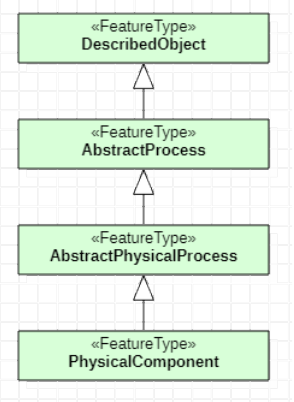
Figure 2. Data model for the PhysicalComponent